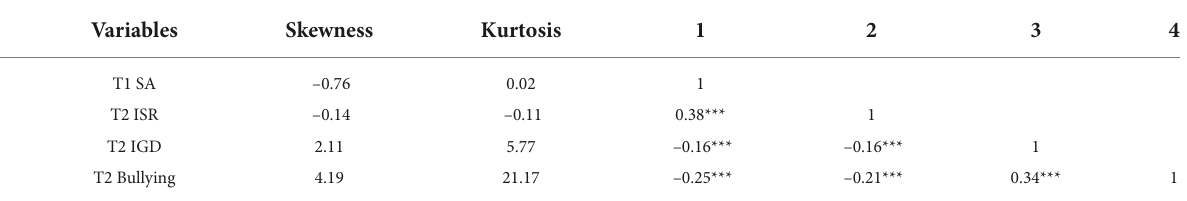
TABLE 2 Skewness, kurtosis, and correlation coefficients of key